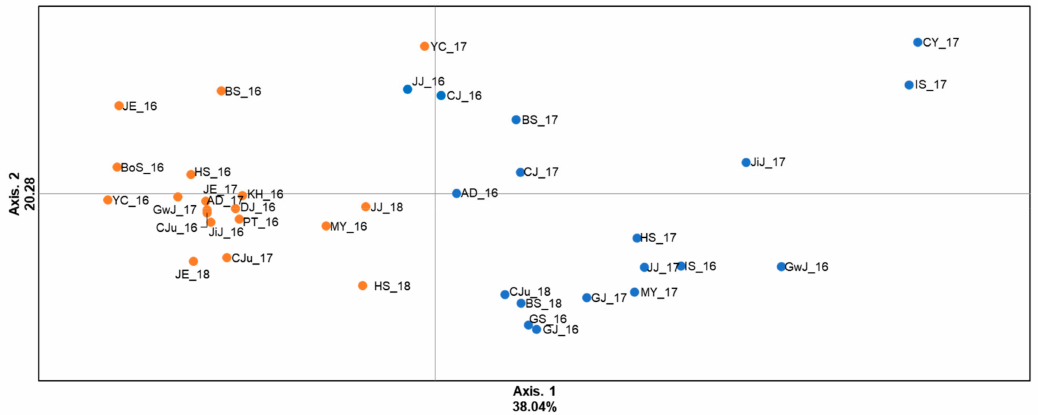
Figure 4. Scatter diagram of factor scores from a principal coordinate analysis of genotype data for eight microsatellite loci in samples of A. gossypii collected from 37 locations in Korea (2016, 2017, and 2018). The percentage of total variation attributed to each axis is